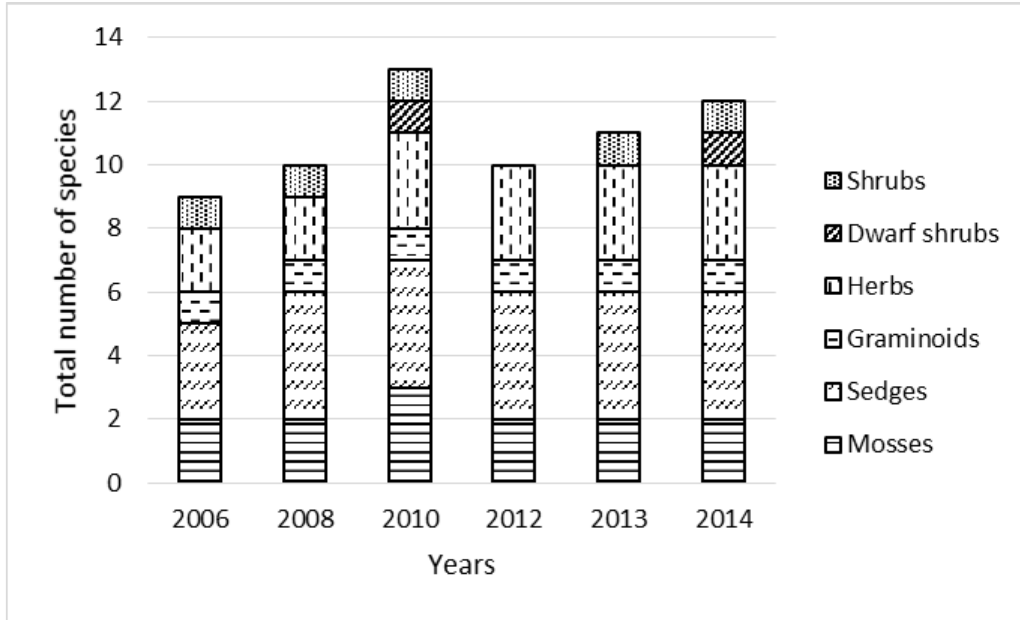
Figure 4. Total number of species in accordance with plant group (shrubs, dwarf shrubs, herbs, graminoids, sedges or mosses) in the Porla wetland, 2006–2014. The species richness of all groups except dwarf shrubs was stable. The dwarf shrub group appeared twice, with one species ( V. oxycoccus ), in 2010 and